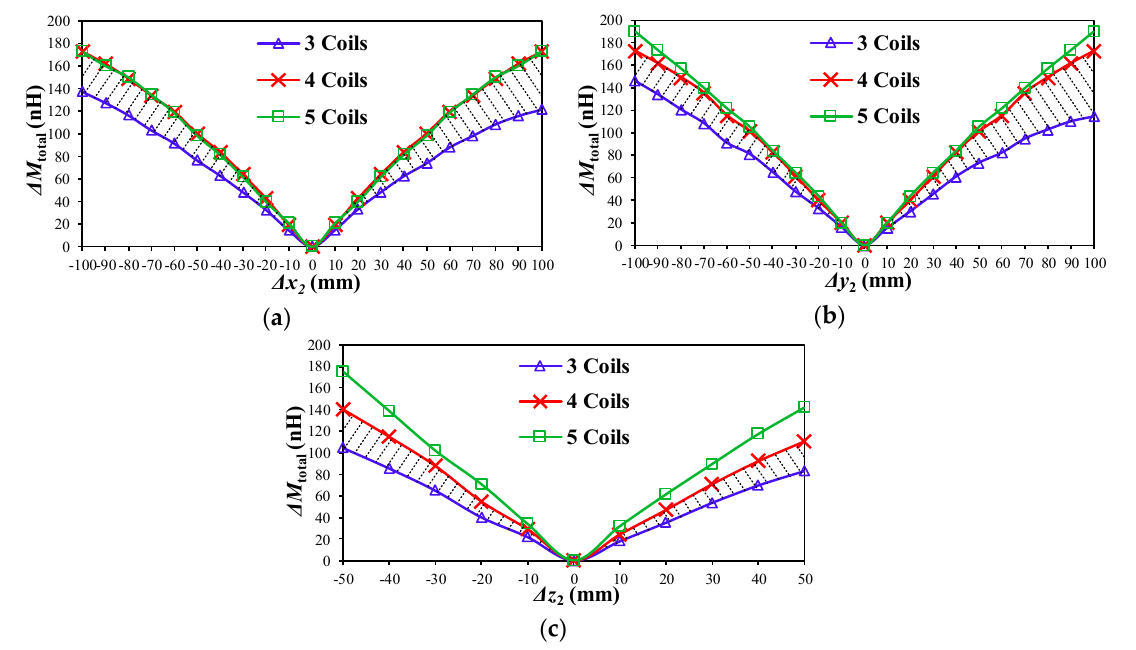
Figure 9. Δ M total obtained by different numbers of signal coils when the secondary coil moves along: Figure 9. ∆ M total obtained by di ff erent numbers of signal coils when the secondary coil moves along: ( a ) x axis; ( b ) y axis; and ( c ) z axis. ( a ) x axis; ( b ) y axis; and ( c ) z